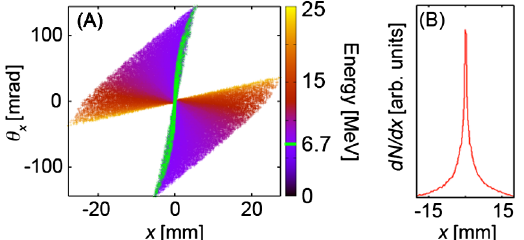
FIG. 9. (A) Phase-space plot for all protons at or above 6.7 MeV for 8.5 T (i.e. protons incident on film layer #2 in Fig. 8). The green points highlight the 6.7 MeV protons. (B) A projection of the phase-space plot onto the x axis illustrates the proton density across the focal